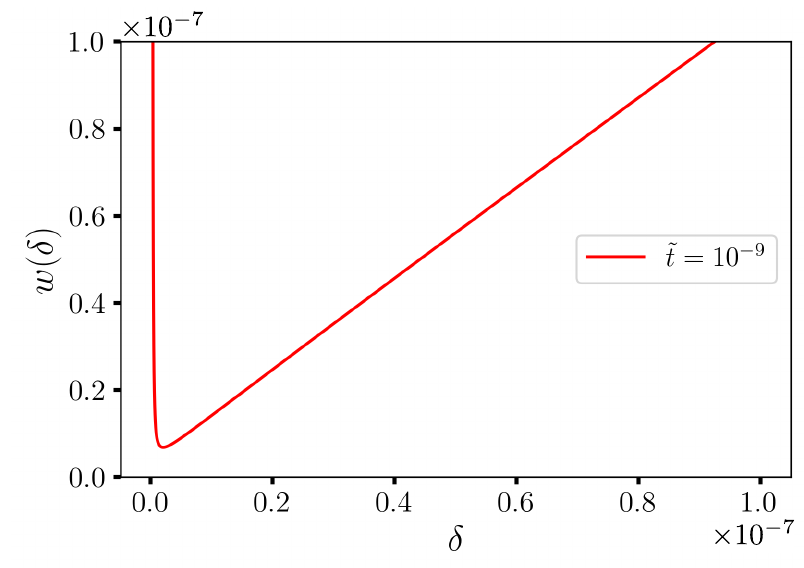
Figure 3. Plot of the semiclassically corrected photon geodesic impact parameter relation. The plot shows a bounce as the distance from the critical radius approaches the semiclassical length scale of ˜ t ∼ 10 − 8 units.